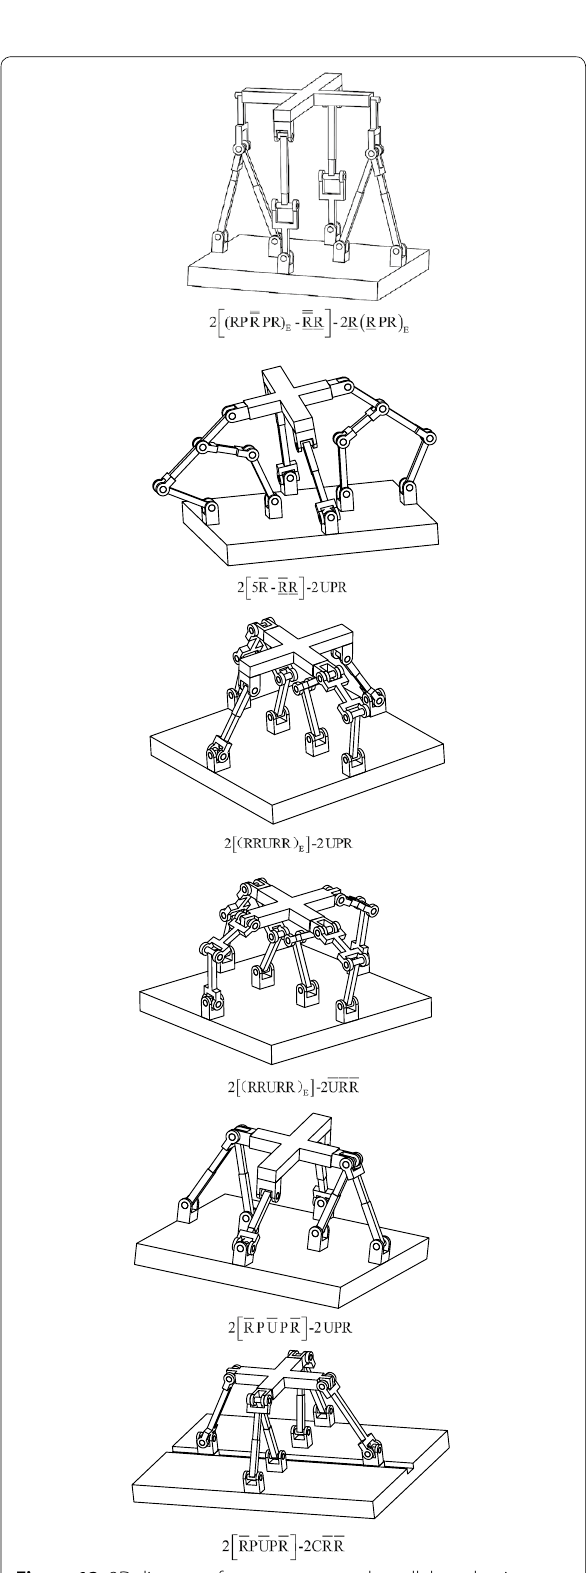
Figure 12 3D diagram of some represented parallel